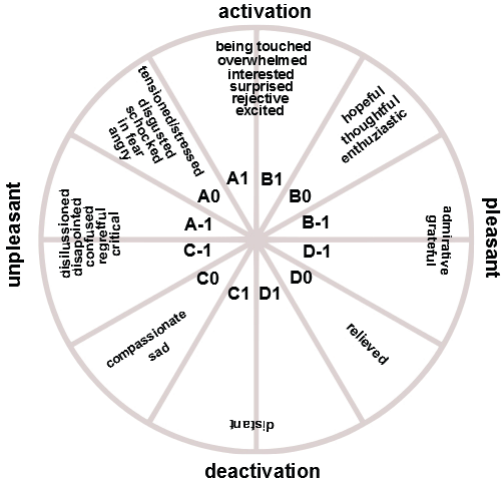
Figure 1. The spectrum of Committee State Security Building visitors’ emotions mapped in accordance to the adapted circumplex model of core affect (Desmet, 2008) (source: created by authors)